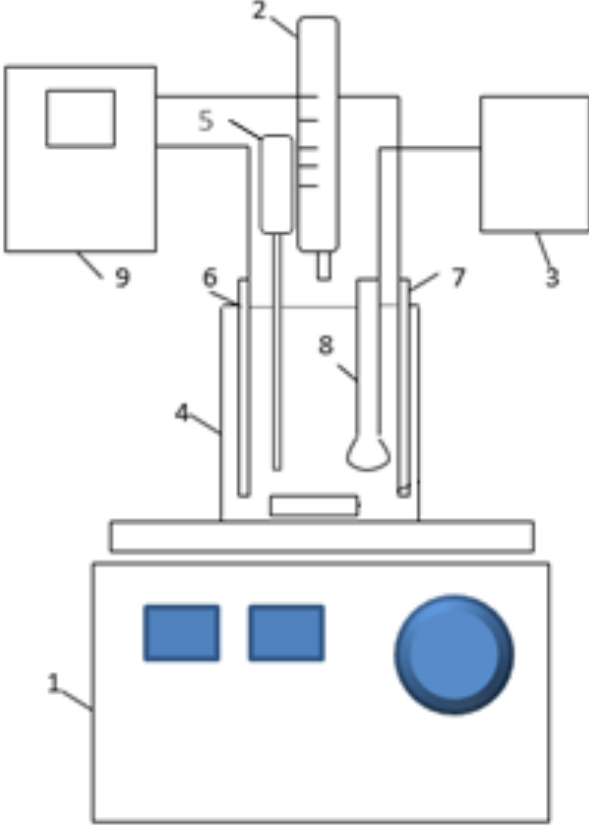
Figure 1. Installation. 1 - magnetic stirrer, heater; 2 - reagent dispenser; 3 - pH-meter; 4 - reactor; 5 - thermometer; 6 , 7 – ohm-metric electrodes; 8 - pH-sensitive electrode; 9 –